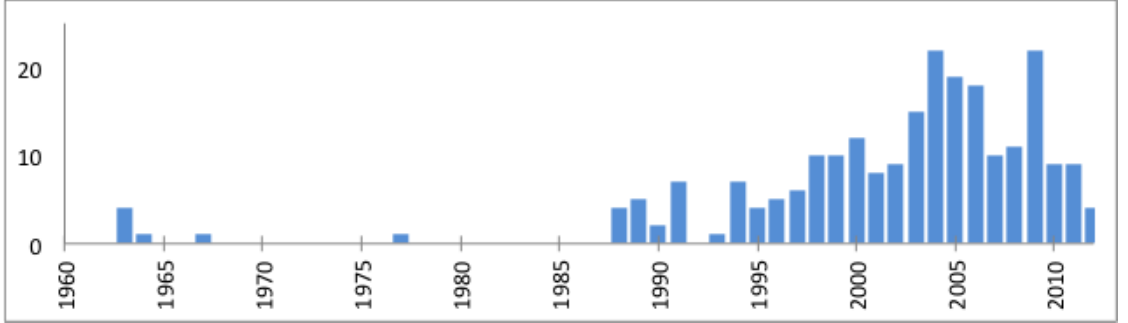
Figure 3. Unmanned VTOL commercial platform systems developed (horizontal axis) by year between 1960–2012. Data for 2012 are estimates at the time of